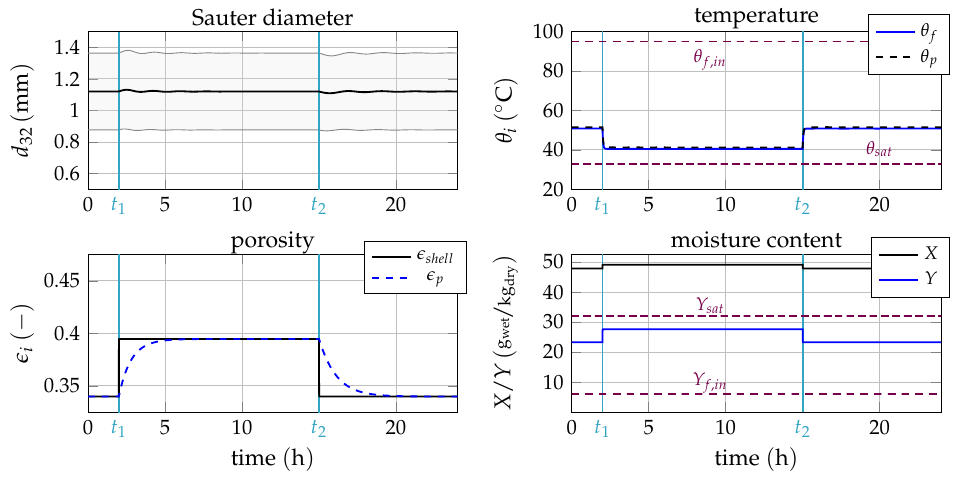
Figure 9. Simulation results of the second scenario: an increase of injection rate ˙ m inj from 40 kg / h to 50 kg / h at t 1 induces variations of thermal conditions, resulting in an increased particle porosity e p . After resetting ˙ m inj to the default value, the dynamic states and particle properties settle at the (initial) steady state again. Regard the different time scales of the step response at t 1 and t 2 illustrated in Figure 10.